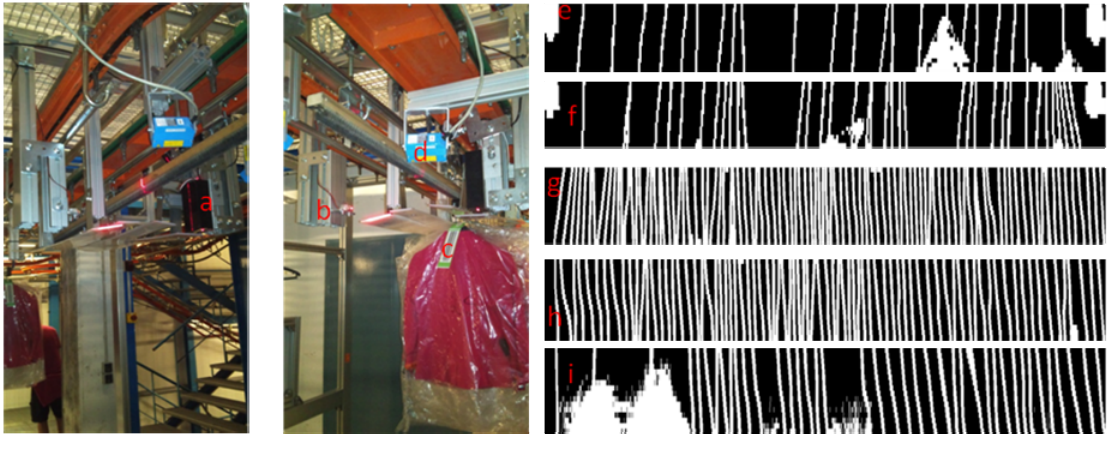
Figure 1. Picture of a garment counter device based on laser imaging in a textile warehouse; ( a ) sensor array and image acquisition electronics, ( b ) laser lineal emitter, ( c ) bar code label for internal traceability of a batch of garments in hangers, ( d ) bar code scanner, ( e , f ) examples of generated images of hanger hooks to estimate the actual number of garment units in a trolley, ( g , h , i ) examples of generated images in continuous chain mode. In (i) noise can be seen due to